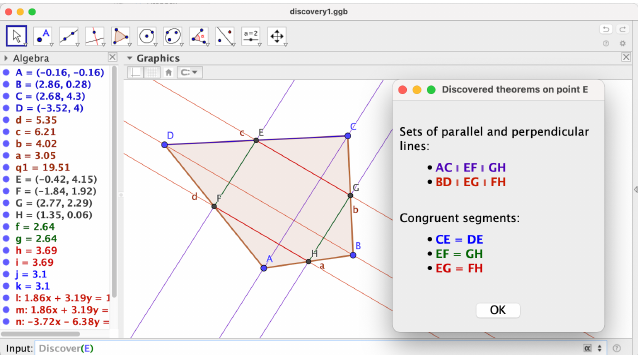
Figure 5. The Discover command yielding different properties involving point E .